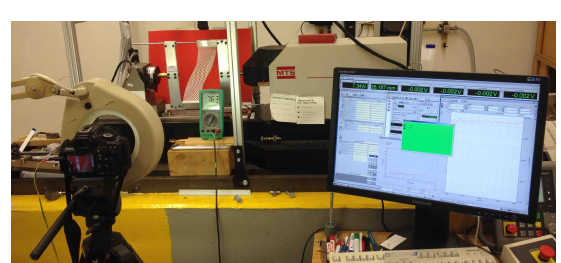
Figure 4. Experimental setup during shear defor- mation: Camera and illumination devices on the left, pantographic sample mounted in an MTS Tytron 250 testing machine in the middle, interface of control software on the